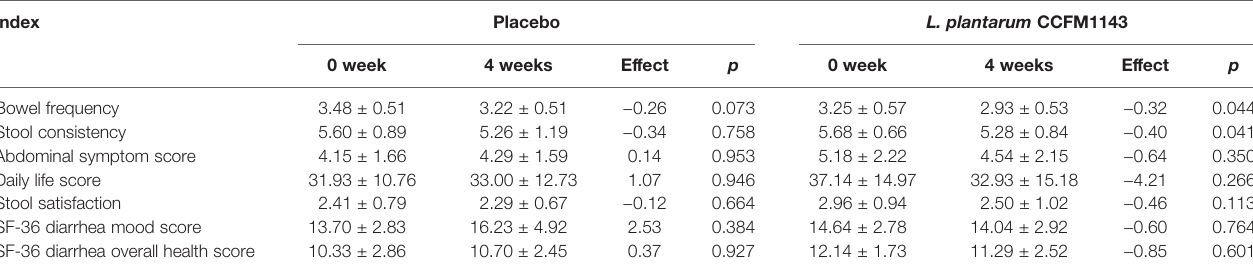
TABLE 4 | Relief scores of L. plantarum CCFM1143. Index